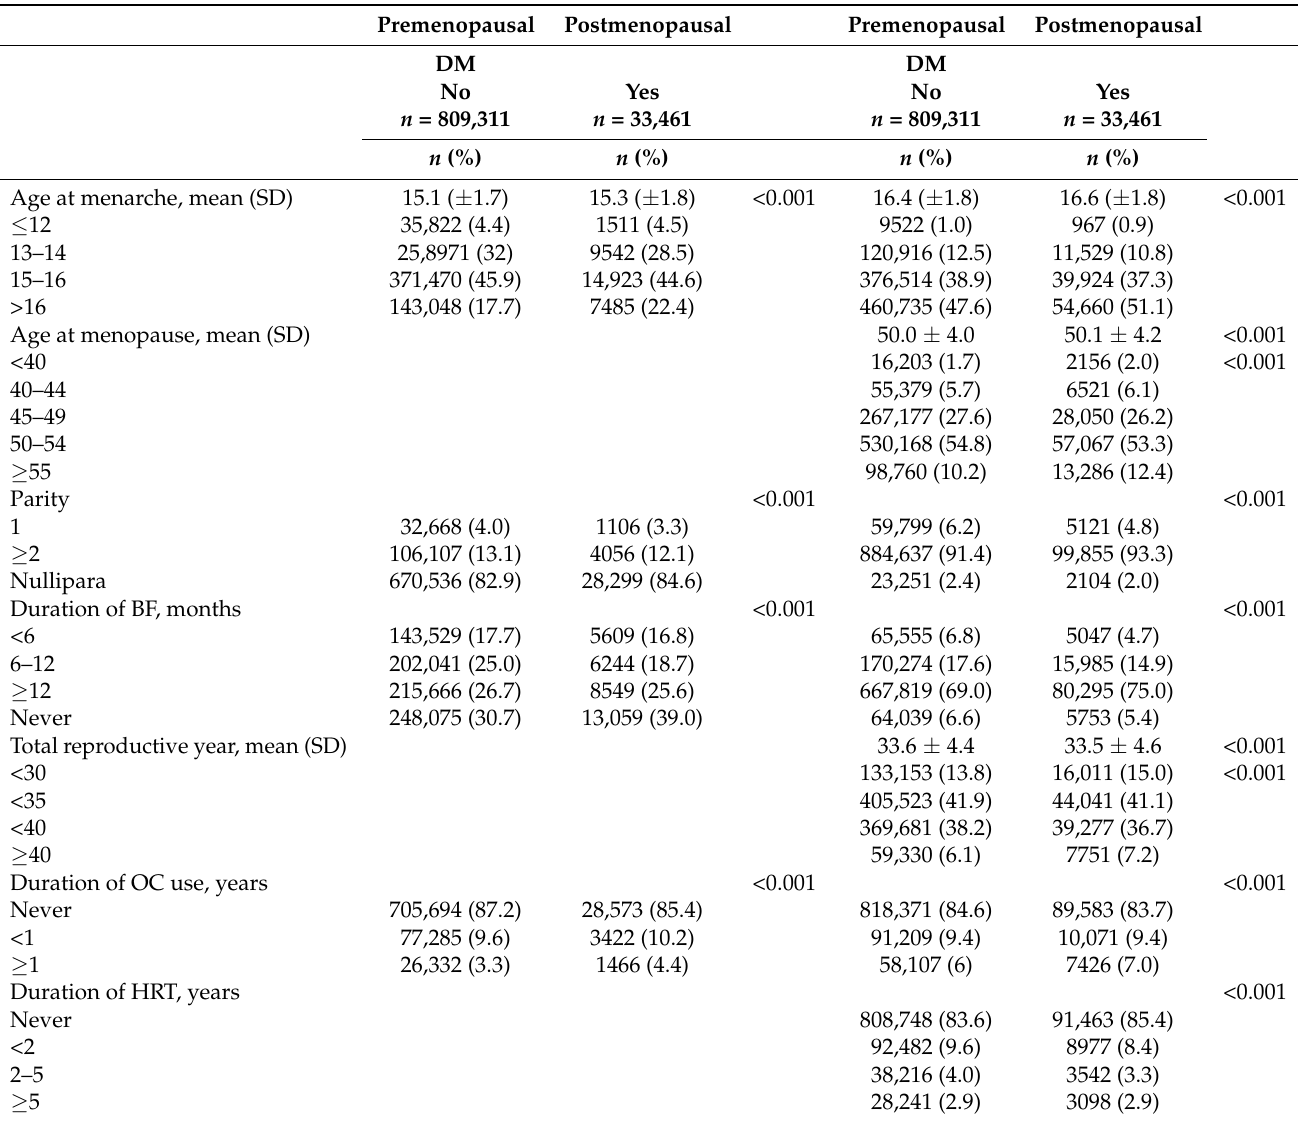
Table 2. Baseline Characteristics related to reproduction of the Study Population according to Menopausal